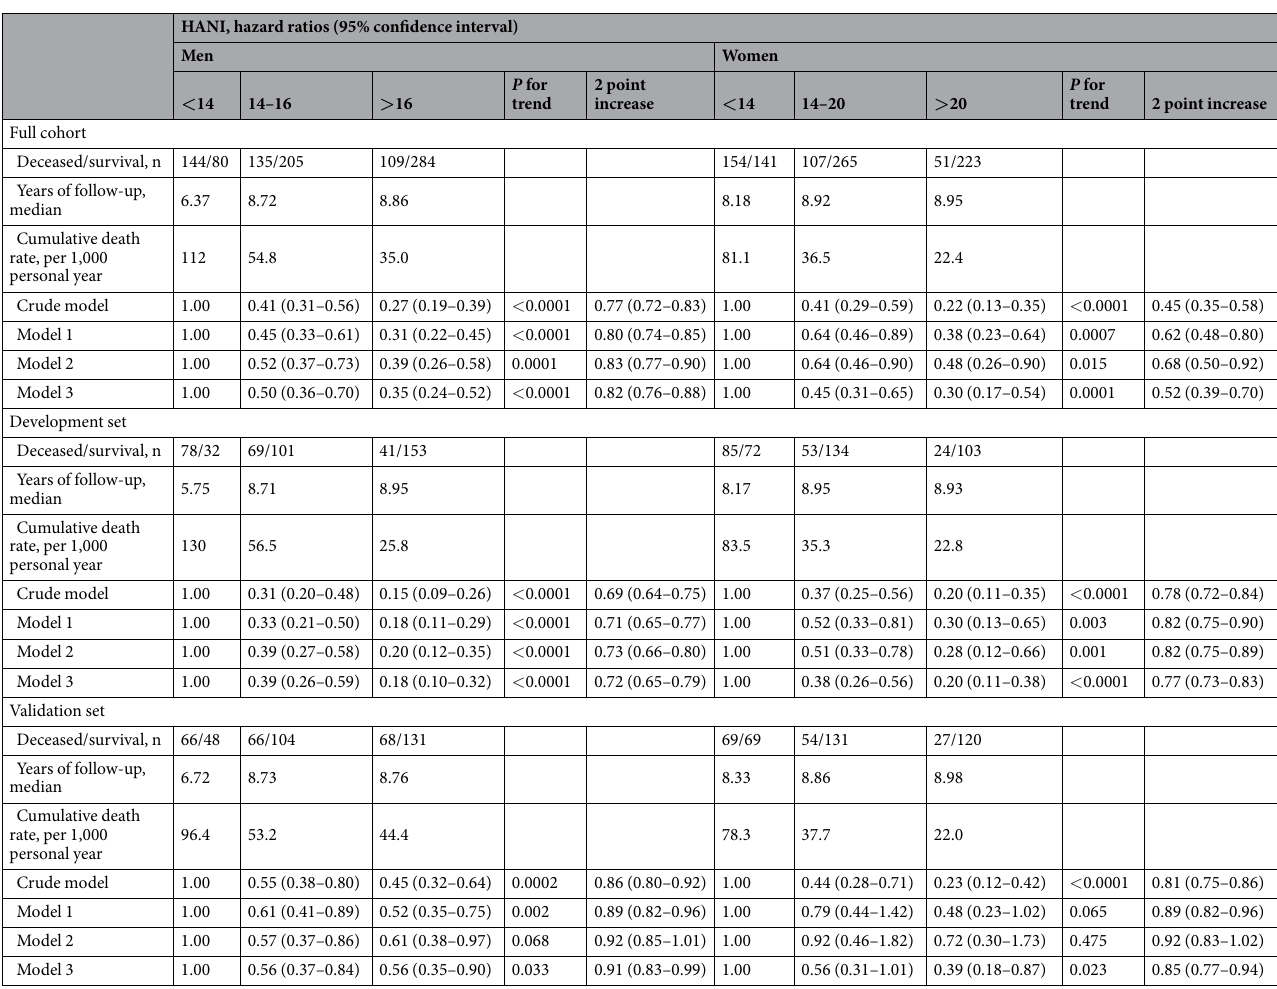
Table 4. Hazard ratios (95% confidence interval) for the association between HANI and risk of all–cause mortality in NAHSIT Elderly by gender. Data were weighted for unequal probability of sampling design by SUDAAN. Hazard ratios were estimated by the Cox proportional hazard model. Model 1: adjusted for age. Model 2: adjusted for age, region, education level, smoking status, physical activity, social engagement, and cognitive impairment. Model 3: adjusted for region, education level, smoking status, physical activity, social engagement, and cognitive impairment. HANI, Healthy Ageing Nutrition Index; NAHSIT, Nutrition and Health Survey in